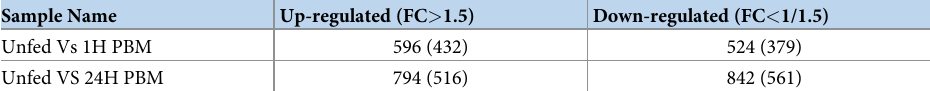
Table 1. Comparison of differentially phosphorylated proteins before and after the blood